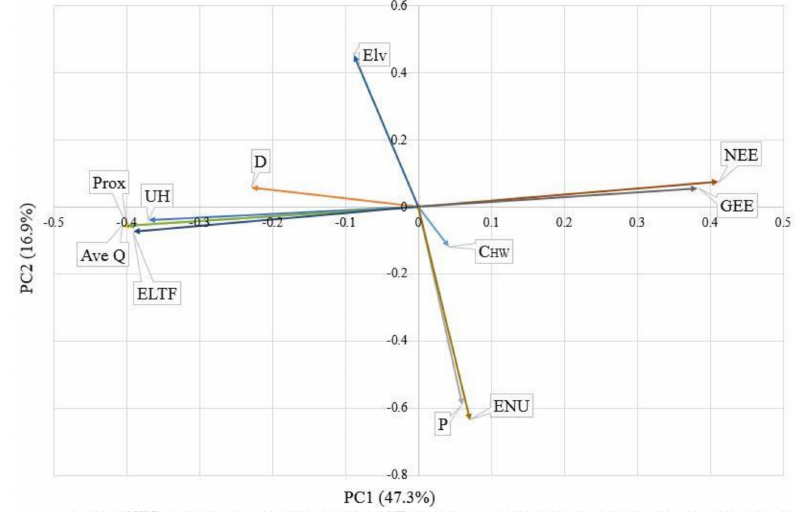
Figure 2. Mono-plot of variables of interest in the non-leaky